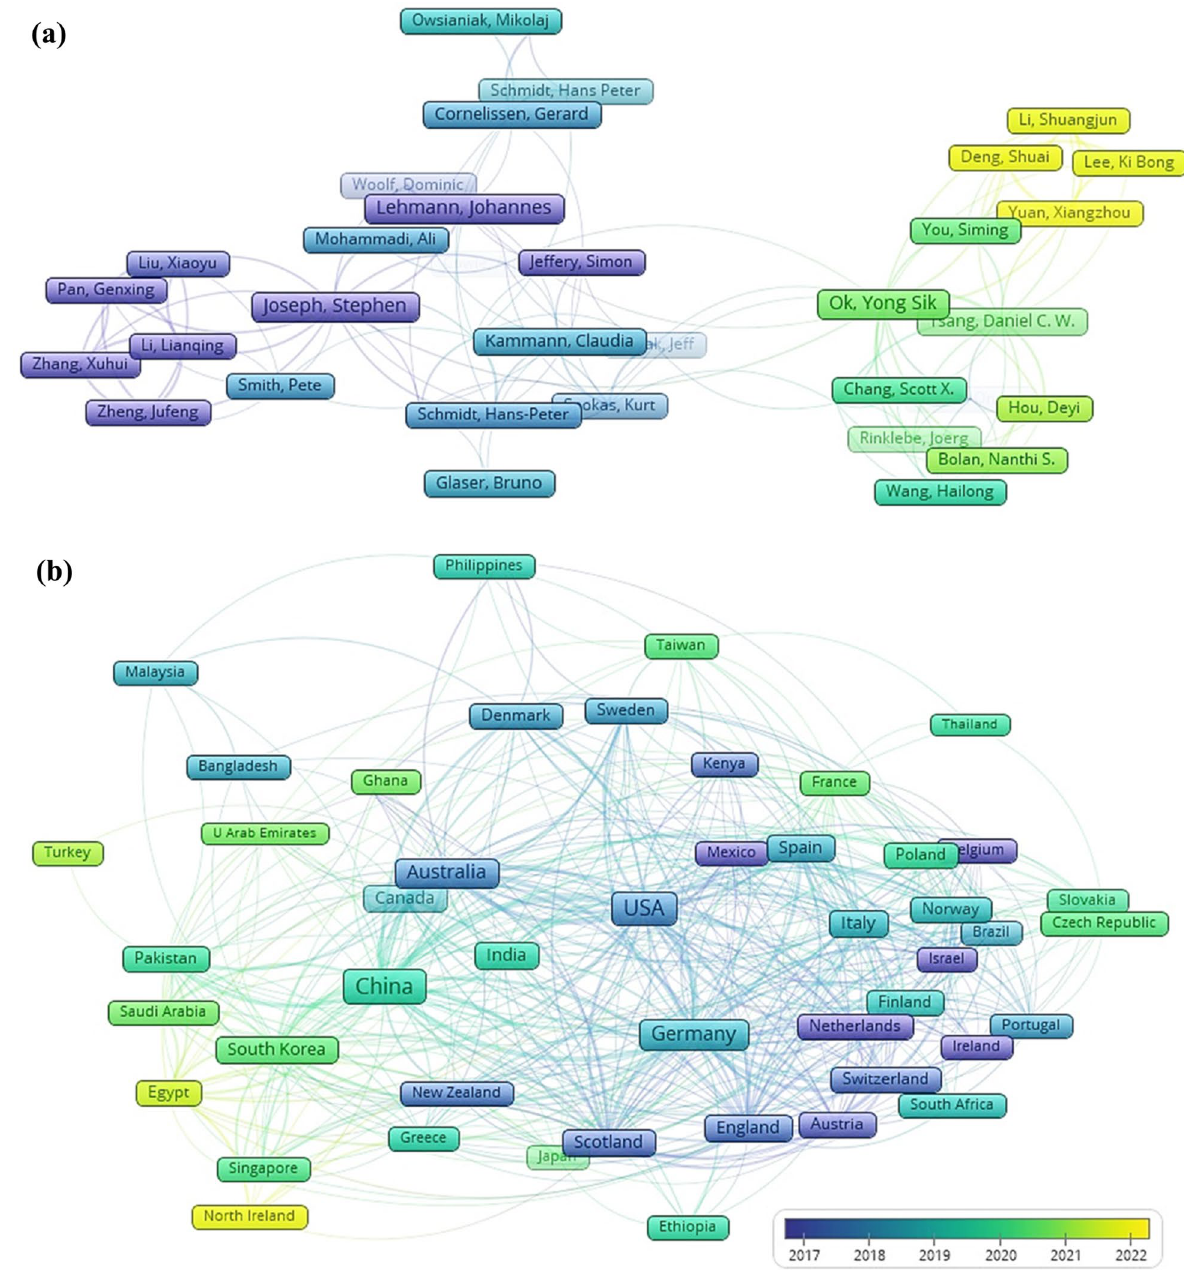
Fig. 3 Bibliometric network for mitigation of climate change between a authors and b countries at minimum 5 document